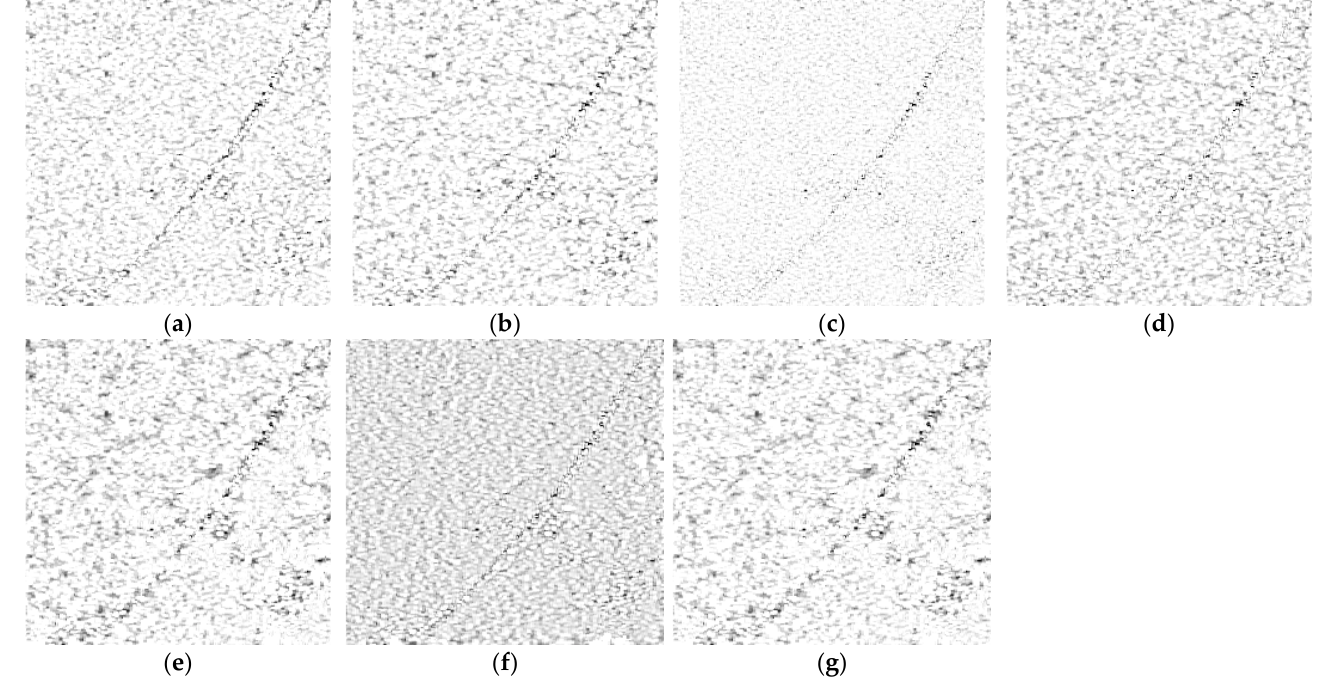
Figure 16. The corresponding ratio images for RS2. ( a ) W-C; ( b ) PPB; ( c ) SAR-BM3D; ( d ) H-WNNM; ( e ) GNLM; ( f ) FANS; ( g ) Proposed method.